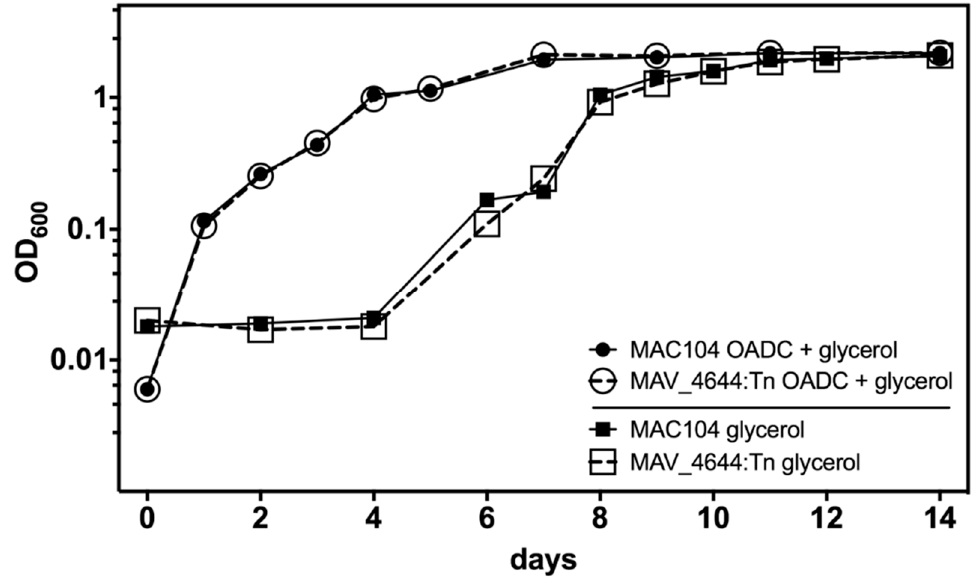
Figure 5. The growth kinetics of MAC104 and MAV_4644:Tn are similar whether assayed in 7H9 broth supplemented with 10% OADC and glycerol, or 7H9 supplemented with glycerol alone. The data is representative of three separate